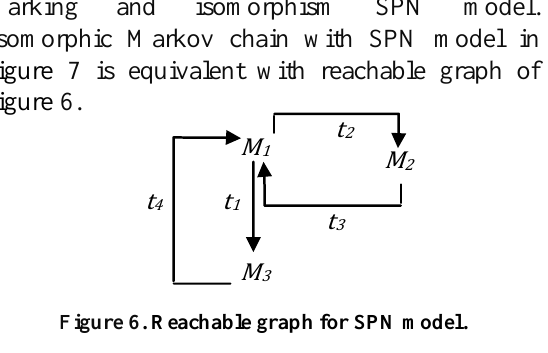
Figure 6. Reachable graph for SPN model.